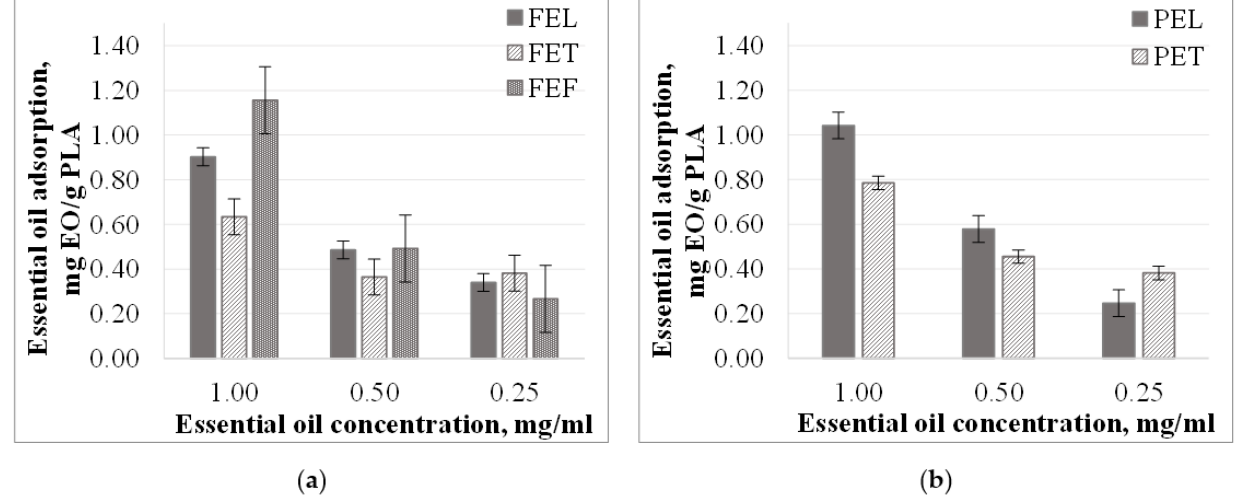
Figure 2. Essential oil adsorption (mg EO /g PLA ) in ethanol solutions in the case of ( a ) particles from F granules; ( b ) particles from P granules.